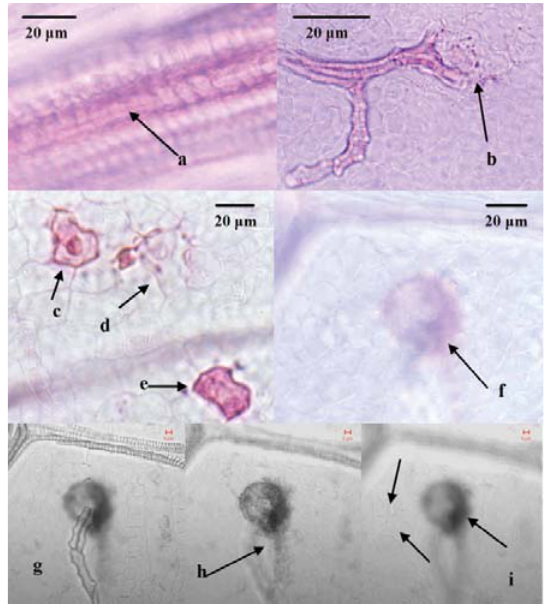
Fig. 1. Occurrence of Acremonium byssoides in non-ino- culated grapevine (cv. Insolia) leaf mesophyll observed by differential interferential contrast light microscopy (a–f) and optical scanning confocal microscopy (55 μ m; g–i). (a) Hyphae in the leaf veins. (b) Intercellular endophytic hyphae in the mesophyll. (c) Fuchsin-stained (red) walls of host epidermal cells indicate A. byssoides evasion. (d) A. byssoides fructi fi cations emerging from among the epi- dermal cells. (e) A group of cells totally stained by fuchsin. (f) Fuchsin-stained granular mass of sub-stomatal tissue, showing the hyphal ribbons of A . byssoides . (g–i) A. byssoides hyphae developing from the vein and extending through the mesophyll to the epidermal